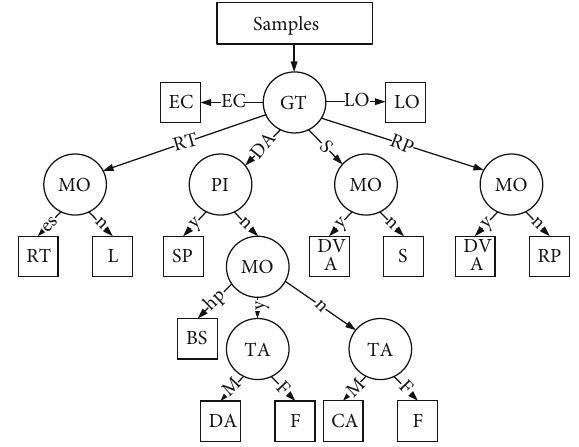
Figure 18: An example of decision tree for cooperative tactical intention